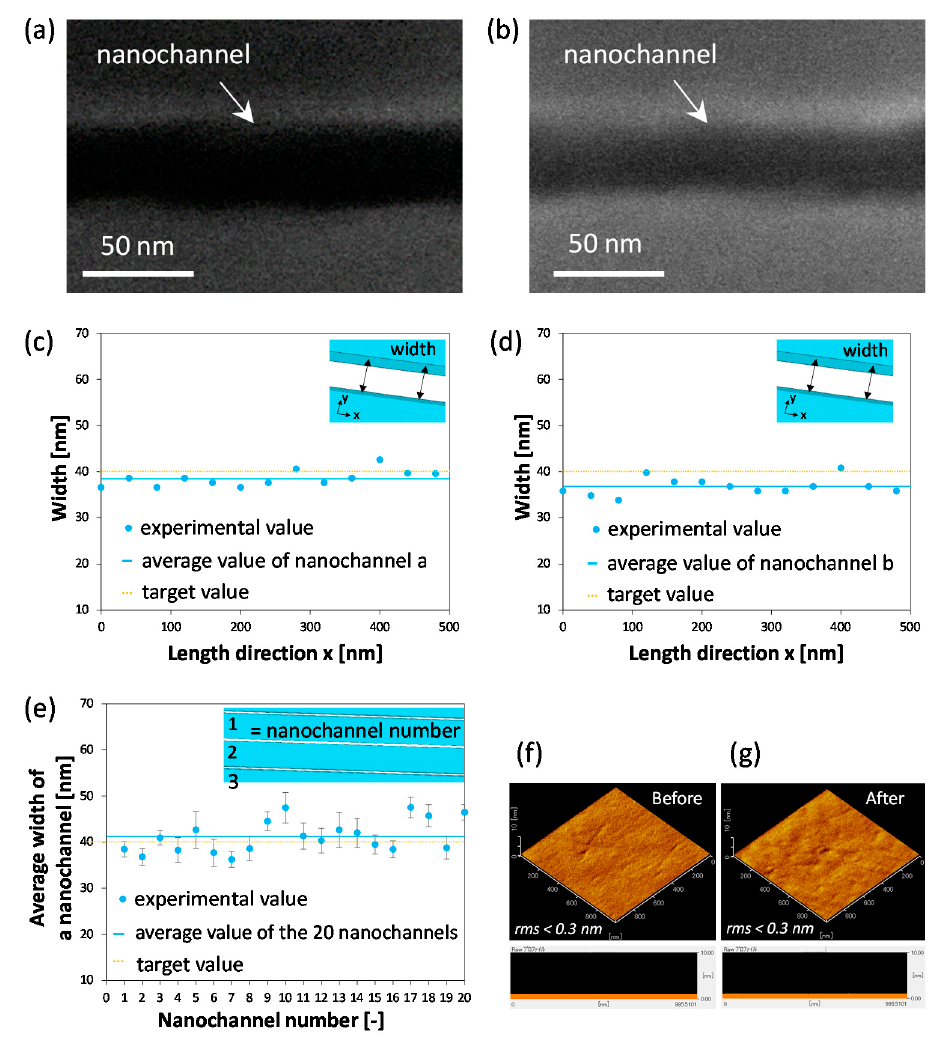
Figure 4. ( a , b ) SEM images of representative ultranarrow nanochannels (32 nm deep) fabricated in glass substrates. ( c , d ) Variation of the width along the length direction of ultranarrow nanochannel shown in (a, b), respectively. ( e ) Variation of the average widths between 20 ultranarrow nanochannels ( n = 13 for each nanochannel). AFM images of glass substrate ( f ) before and ( g ) after nanofabrication.